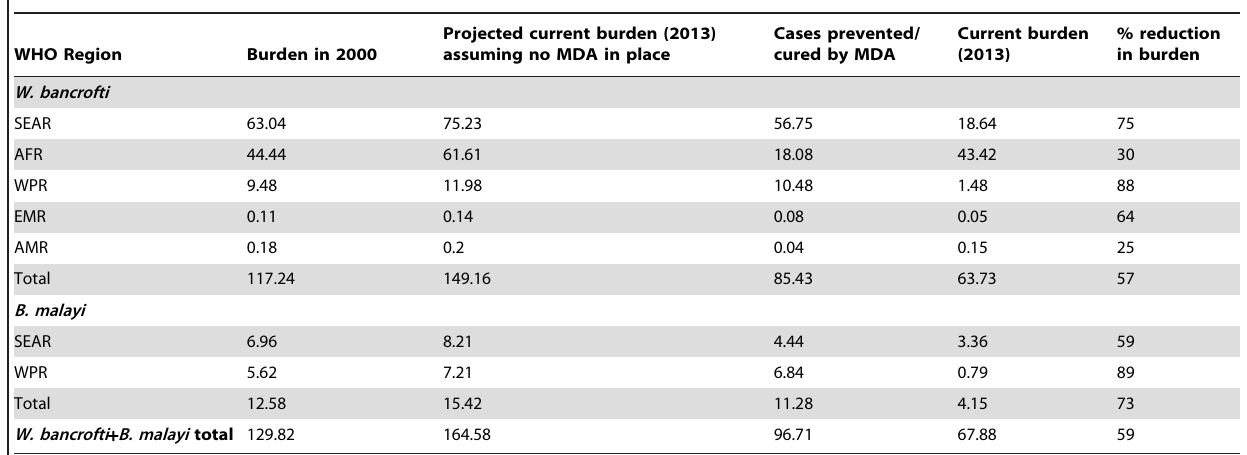
Table 3. Estimated number of LF cases prevented by the MDA programme under GPELF and current burden in different regions.